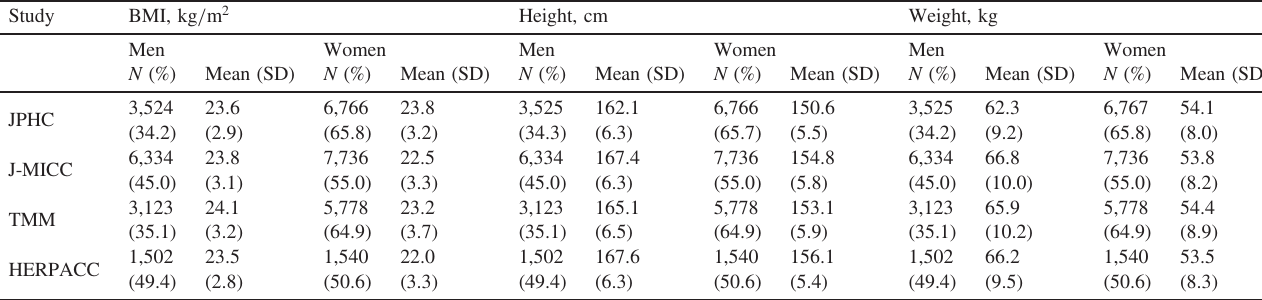
BMI, body mass index; HERPACC, Hospital-based Epidemiologic Research Program at Aichi Cancer Center; J-MICC, Japan Multi-Institutional Collaborative Cohort Study; JPHC, Japan Public Health Centre-based Prospective Study; SD, standard deviation; TMM, Tohoku Medical Megabank Community-Based